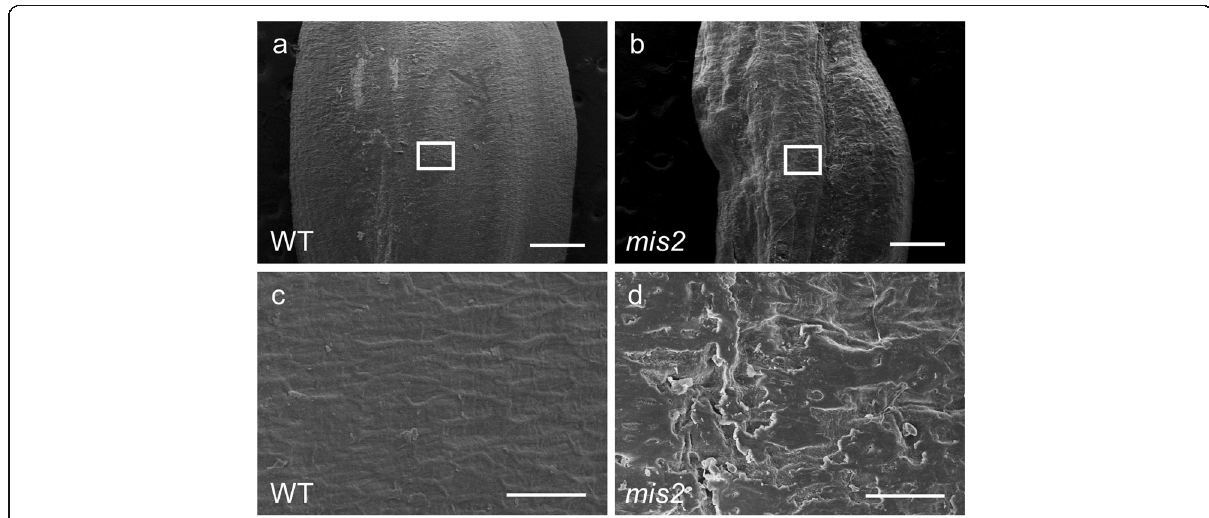
Fig. 3 Morphological comparison of seed surface between WT and mis2 . ( a , b ) SEM for the surface of WT and mis2 seed. Bar = 0.5 mm. ( c , d ) Magnified views of the boxed region in ( a , b ), respectively. Bar = 50 μ